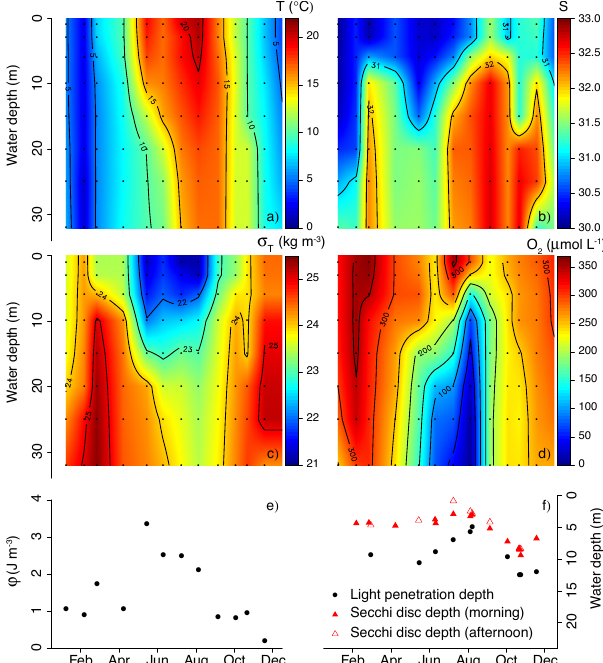
Figure 3. (a) Temperature ( ◦ C), (b) salinity, (c) density anomaly (kgm − 3 ), (d) O 2 (µmolL − 1 ), (e) stratification parameter φ (Jm − 3 ) and (f) light penetration and Secchi disc depths at the Den Osse basin in 2012. Black dots in (a–d) indicate measurements. Data from (a–d) were linearly interpolated in space and